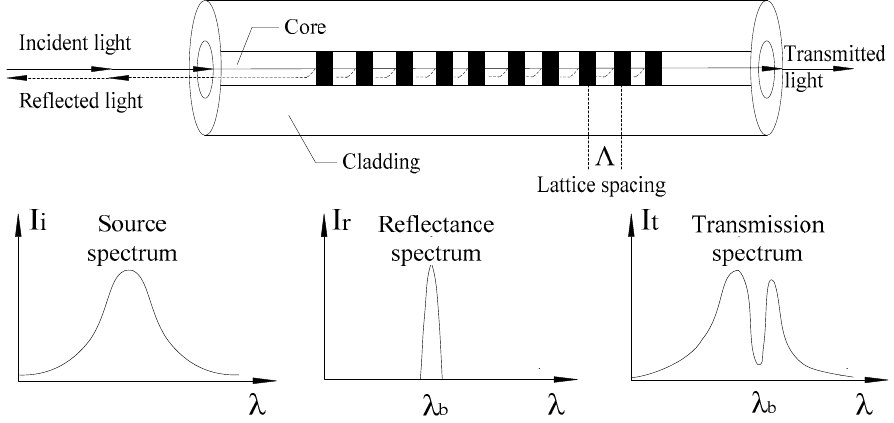
Figure 5. Fiber Bragg grating (FBG) quasi-distributed measurement principle. Where I i is light source spectrum; I r is the reflection spectrum; I t is the conduction spectrum; λ is the fiber Bragg grating wavelength (nm); and λ b is the fiber grating center wavelength (nm).